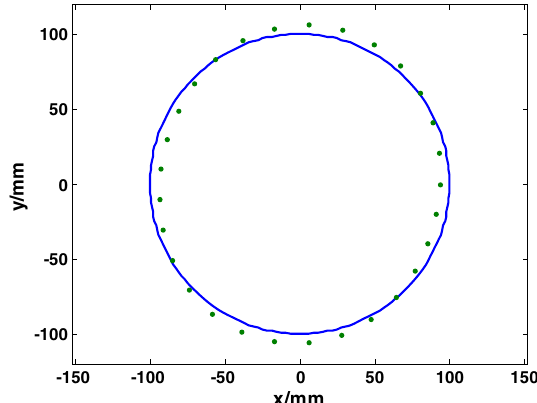
Fig. 3. Null space data generation for a least squares circle fit, simulating scale and squareness errors associated with the coordinate measuring